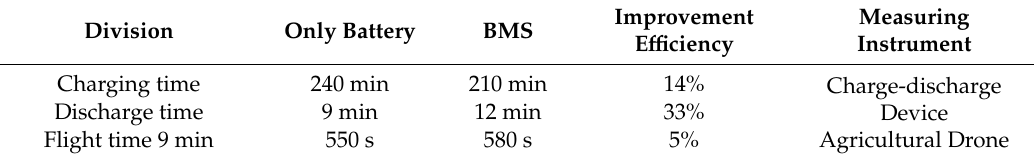
Table 9. Comparison of outcomes with the battery only and the BMS.